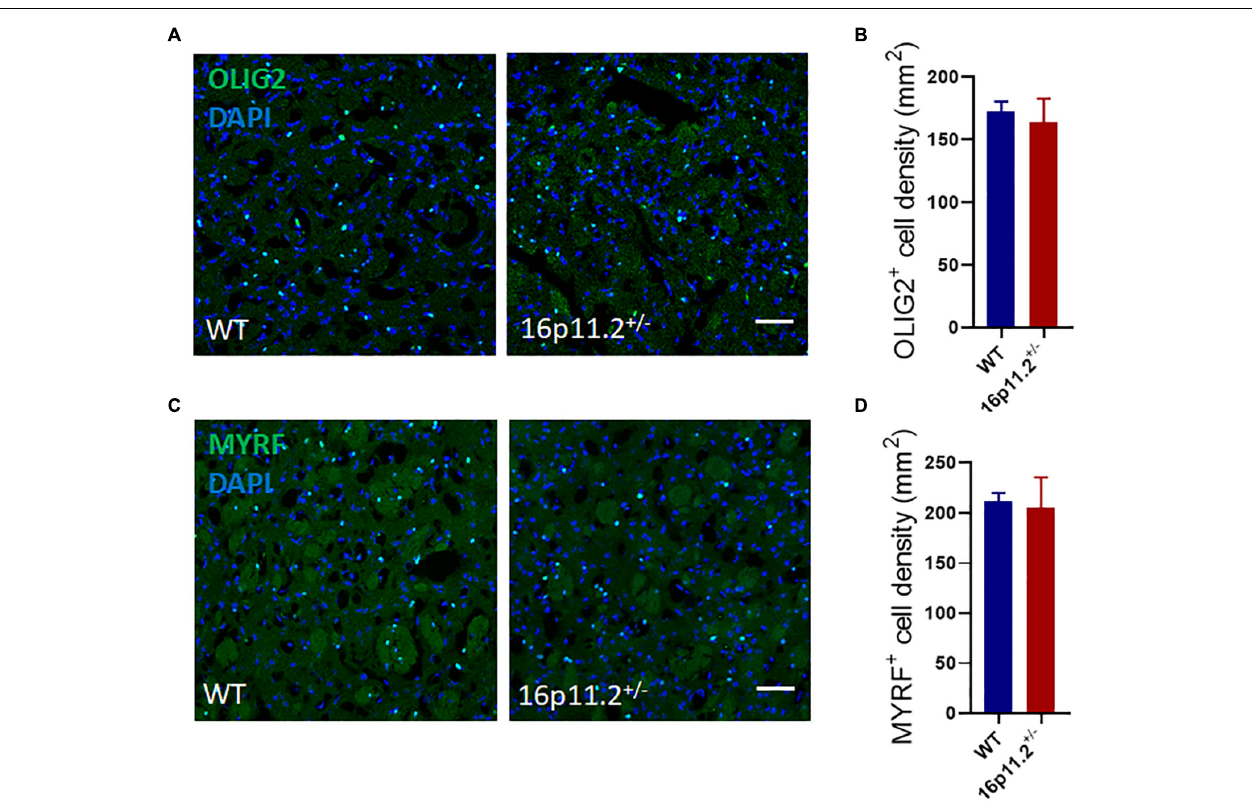
FIGURE 3 | Oligodendrocyte lineage cell numbers are unchanged in 16p11.2 ± striatum. (A,C) Representative images of OLIG2 + [green, (A) ] oligodendrocyte lineage cells and MYRF + [green, (C) ] differentiated/mature oligodendrocytes in striatum sections of P60 16p11.2 ± mice and WT controls. Nuclei were counterstained with DAPI (blue). (B,D) Comparison of OLIG2 + (B) and MYRF + (D) cell numbers in the striatum of 16p11.2 ± mice versus WT controls, showing no significant differences (data from 4 mice per group, mean ± SEM, unpaired t test). Scale bar = 50 µ m.